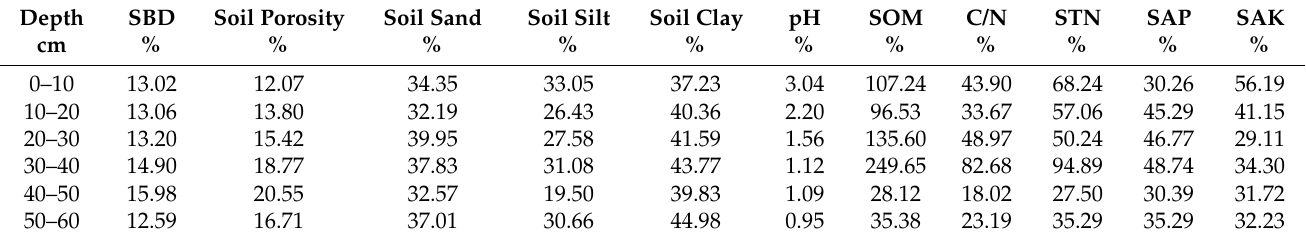
Table 2. Variation coefficients of soil physicochemical properties at different